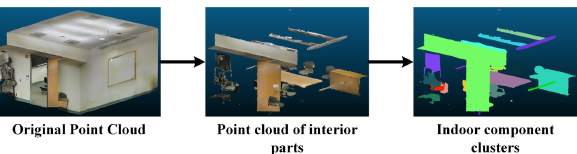
Figure 4. The process of indoor component clustering and